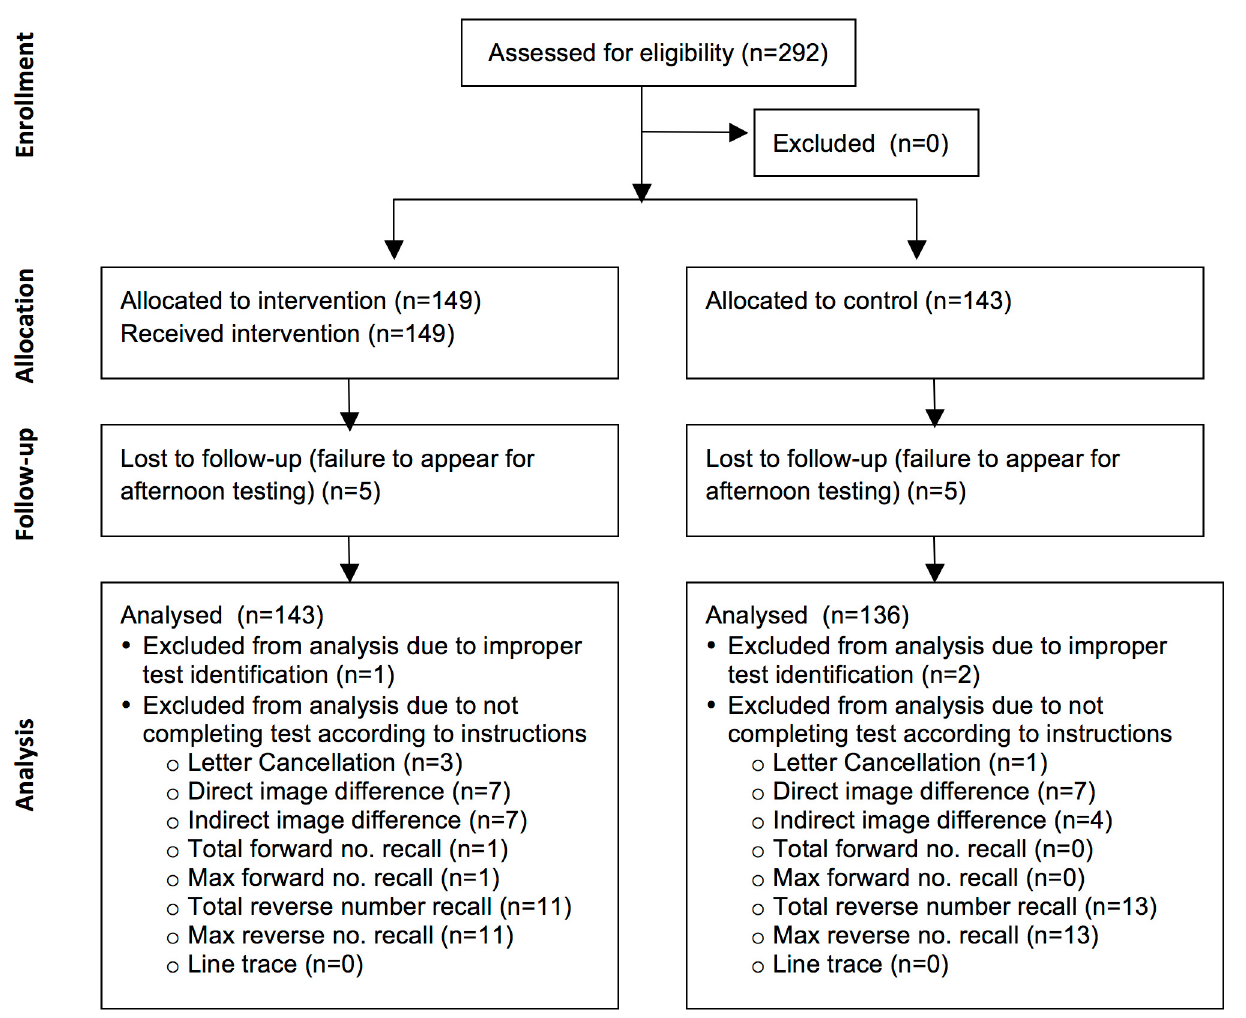
Fig 1. Flow diagram of pupil